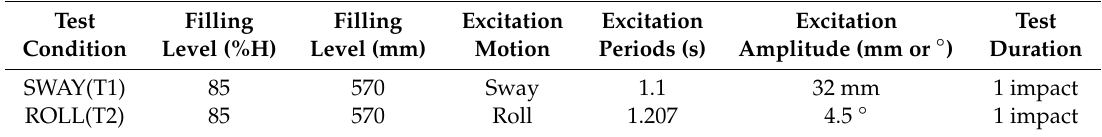
Table 6. Test conditions.